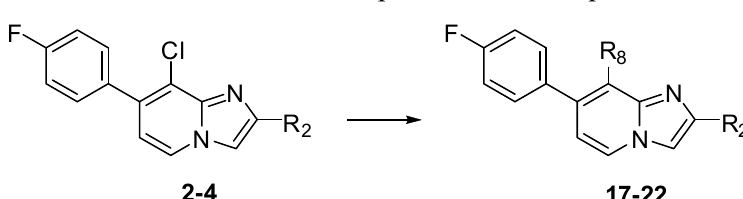
Table 1. Functionalization in position 8 of compounds 2 – 4